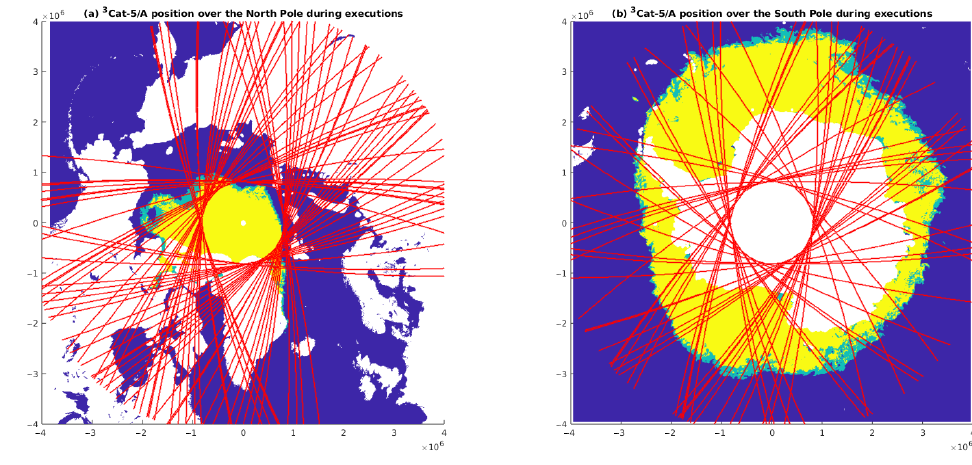
Figure 2. ( a ) North Pole tracks of FMPL-2 executions in LAEA coordinates, and ( b ) South Pole tracks of FMPL-2 executions in LAEA coordinates. Both figures with OSISAF Sea-ice edge product (in blue-green-yellow)